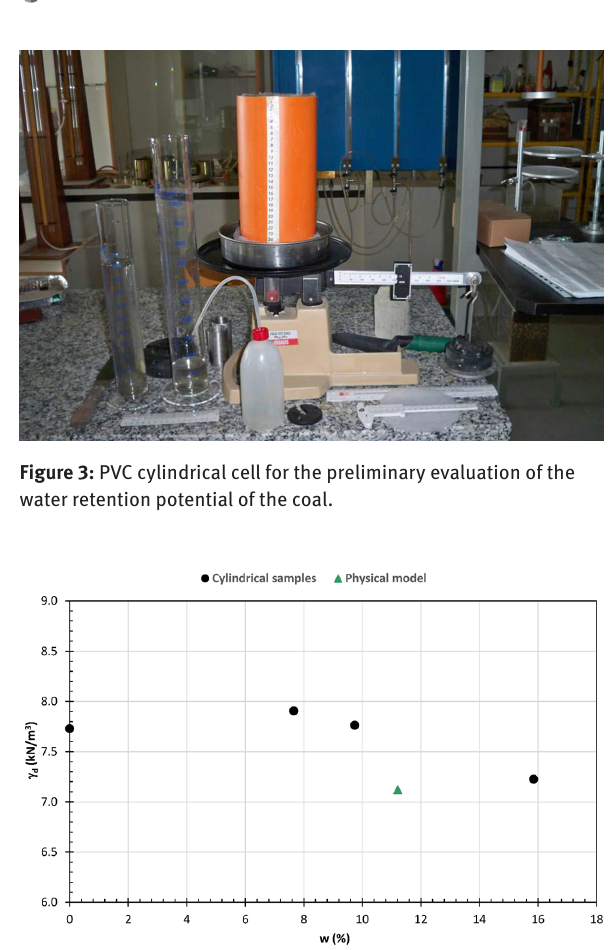
Figure 4: Dry unit weights of coal cylindrical samples and physical